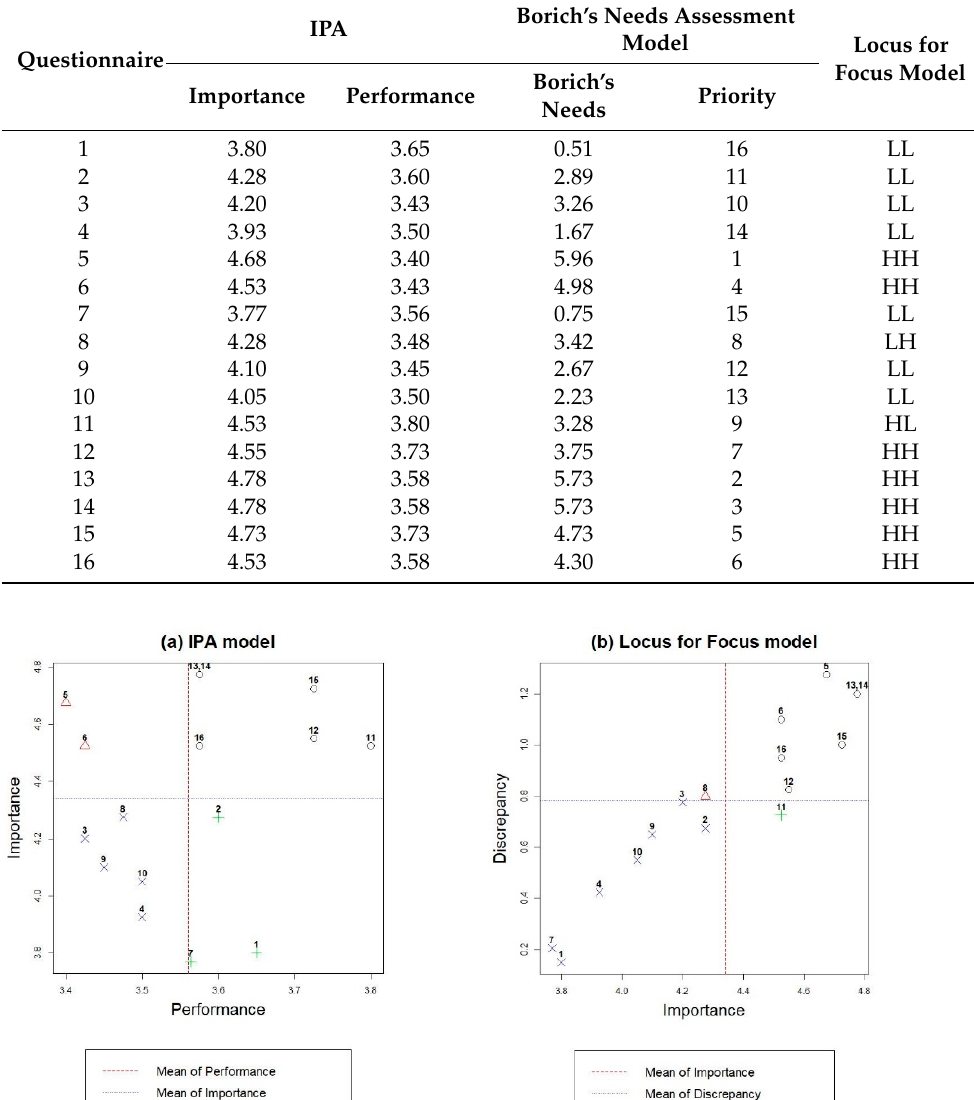
Table 6. IPA, Borich’s need assessment, and the locus for focus model for the Sewol ferry accident.